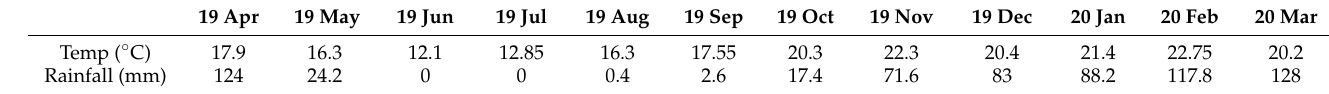
Figure 1. The location of the study area (28°55 ′ 26.83 ″ S, 29°33 ′ 38.64 ″ E, 1038 m above sea level). Table 1. Total rainfall and average temperature received between April 2019 and March 2020 (Zulu et al., 2022).